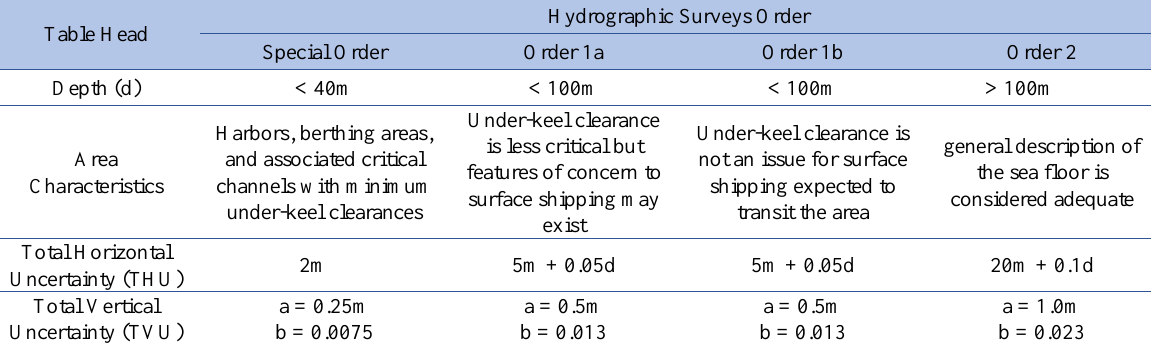
Table 1. IHO Minimum Standards for Hydeographic Surveys (IHO, 2008)